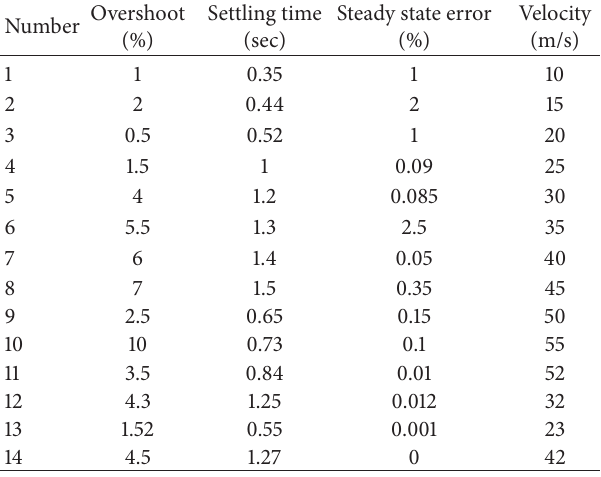
Table 1: System specifications. Table 2: The test data values set used in the BPN.